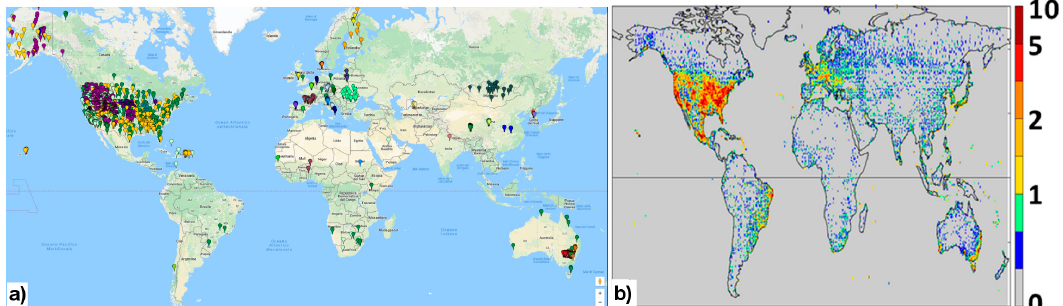
Figure 1. ( a ) Global distribution of soil moisture stations available at the International Soil Moisture Network from January 2000 ([7]); different colours refer to different networks; ( b ) Density of rain gauges underlying the Climate Prediction Center Unified Gauge ‐ Based Analysis of Global Daily Precipitation (number of gauges/0.5°). Even though the two maps are not directly comparable, it is evident that the number of soil moisture stations is much lower than precipitation gauges, and, except in USA and Europe, soil moisture data are nearly absent.